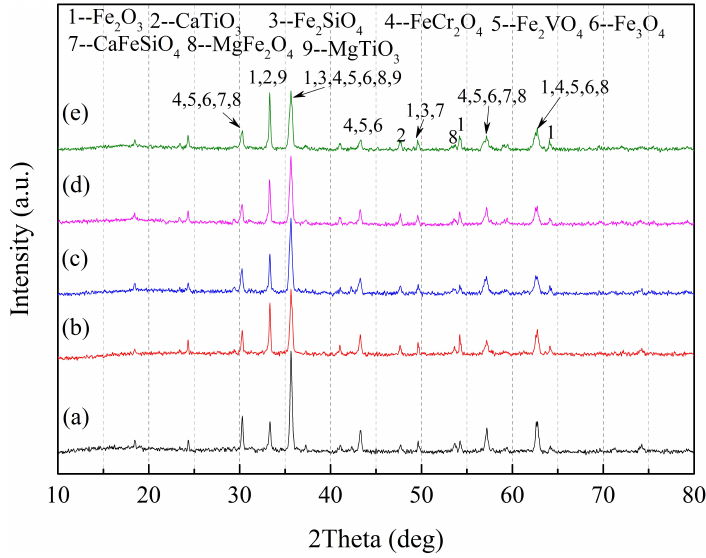
Figure 4. XRD pattern of CVTM sinter with different TiO 2 content. (a) TiO 2 = 5.85%; (b) TiO 2 = 7.35%; (c) TiO 2 = 8.85%; (d) TiO 2 = 10.35%; (e) TiO 2 = 11.85%.